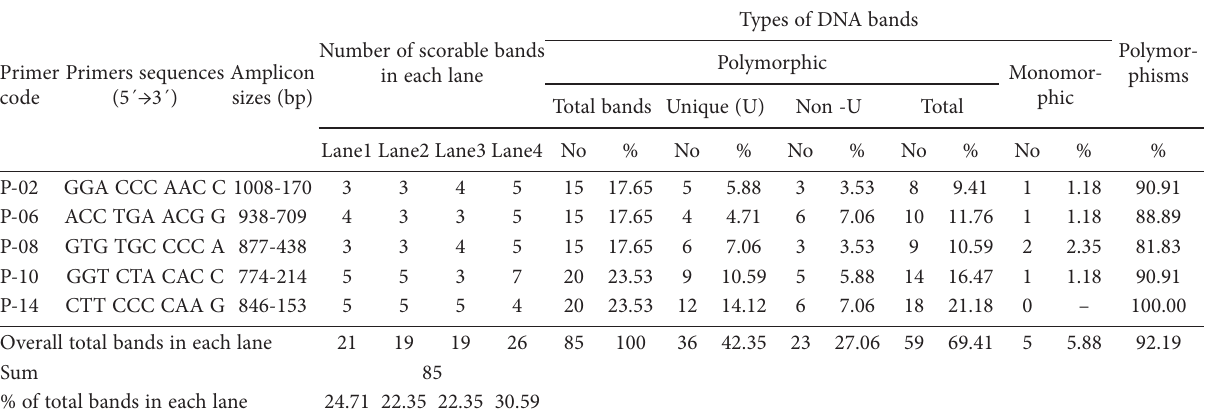
Table 6. Amplification banding patterns and genomic template stability (GTS) of nuclear DNA analyzed by RAPD-PCR isolated from EMF non-exposed and exposed Zea mays seedlings for days of exposure times (Ex-0, Ex-1, Ex-3,and Ex-5) and analyzed by Bio-One D++ soft- ware (Vilber Lourmat, France). Lanes 1–4 represented the days of exposure times (Ex-0, Ex-1, Ex-3,and Ex-5),